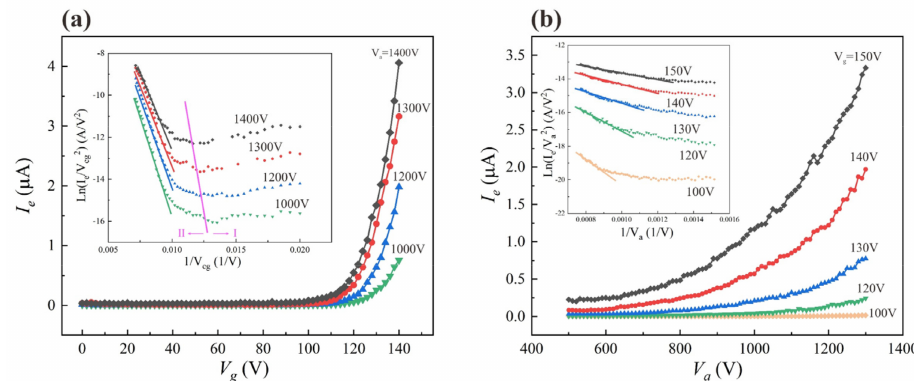
Figure 8. ( a ) Curves of field emission current and gate voltage (I e − V g ) at different V a values; ( b ) curves of field emission current and anode voltage (I e − V a ) at different V g values. The inset shows the corresponding F–N plots.